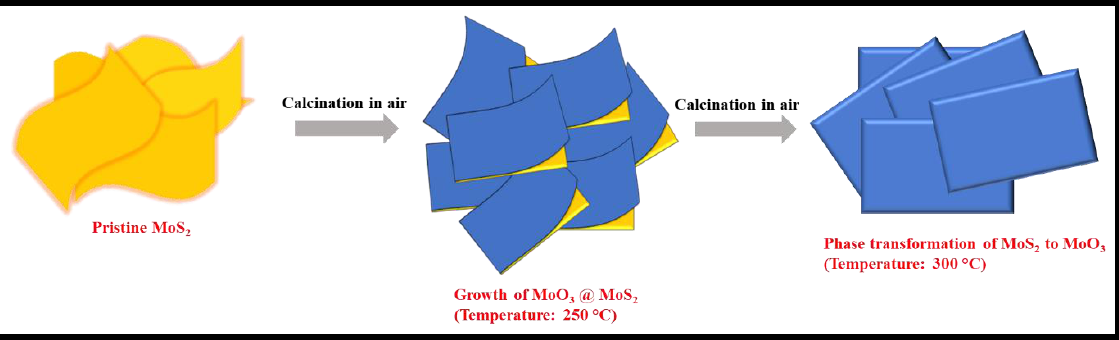
Scheme 2. Schematic of the phase transformation of MoS 2 between (~200 and ~300) °C. The morphology and phase information of MoS 2 , MoO 3 @MoS 2 , and MoO 3 nanostruc- tures are further elucidated by TEM/EDS analysis, as depicted in Figure 5. The typical sheet-like morphology of MoS 2 is further confirmed by TEM images (Figure 5a,b). The selected area electron diffraction (SAED) patterns in Figure 5c displays three diffraction rings for the (002), (100), and (103) lattice planes, indicating the hexagonal MoS 2 polycrys- talline structure (JCPDS # 37 – 1492). After introducing MoO 3 , the sheet-like structures of MoS 2 are partially broken, as seen in Figure 5d,e. An enlarged TEM image shows d 002 edges of the MoS 2 phase (Figure S6 of the SI). The MoO 3 @MoS 2 diffraction ring intensity appears weaker and blurrier than MoS 2 on the SAED (Figure 5f), but likely relates to the MoS 2 phase. This indicates that the sulfide phases are oxidized on the surface and turn into MoO 3 phases, which disrupts the MoS 2 crystallinity. These observations are consistent with the XRD and XPS results (Figures 2a and 3). In comparison, the cuboid-shaped MoO 3 (Figure 5g,h) shows entirely different SAED patterns (Figure 5i). The TEM-EDS elemental mapping (Figure 5j) indicates the uniform distribution of the Mo, S, and O species in the MoO 3 @MoS 2 particles. It is evident that sulfur (red) exists within the particle’s core bodies, while oxide (green) is present at the surface, entirely covering the core. Figure S7a – c shows the BET sorption isotherm of MoS 2 , MoO 3 @MoS 2 , and MoO 3 samples. The type-III iso- therm profiles and absence of a hysteresis loop suggest the low porosity of all the materi- als. The BET surface area of MoS 2 , MoO 3 @MoS 2 , and MoO 3 is only 8.71, 8.42, and 9.85 m 2 g – 1 , respectively (Table S2). The pore distribution curve (Figure S7d) indicates the presence of only interparticle porosity.